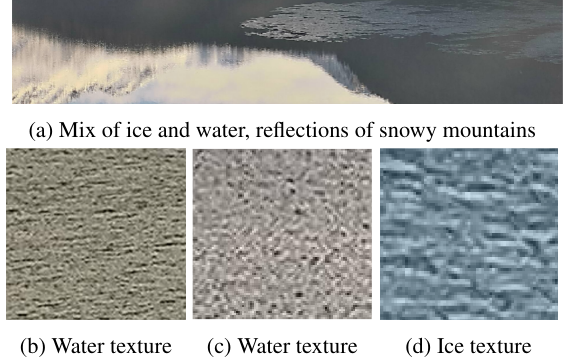
Figure 1. Examples of lake textures observed with